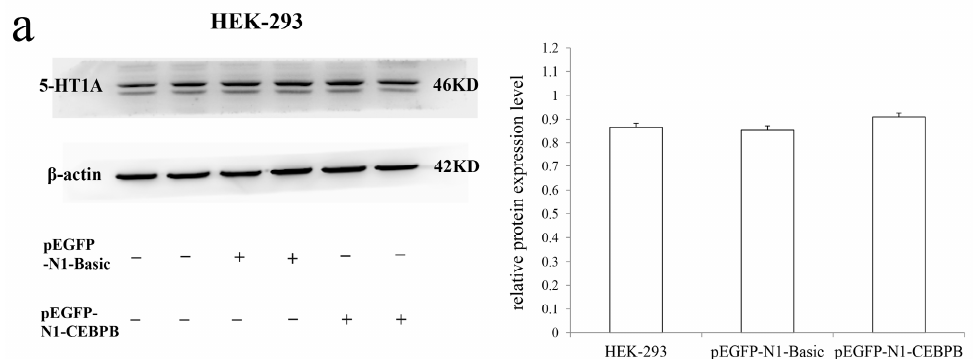
Figure 6. Cont Figure 6. Cont. Figure 6. Cont.